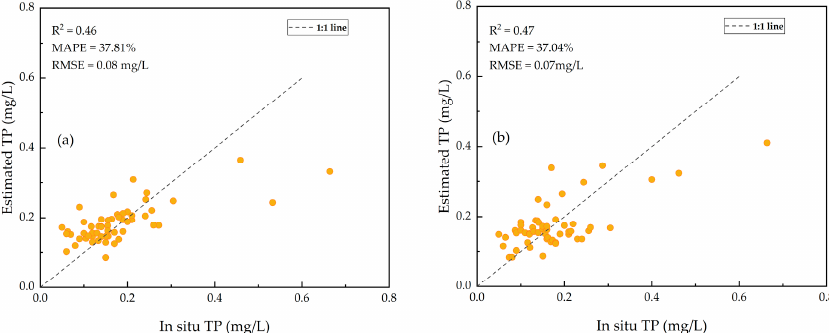
Figure 10. Performance evaluation of TP retrievals using the SVR for Sentinel-2 ( a ) and the XGBoost 312 for ZY1-02D ( b ). 313